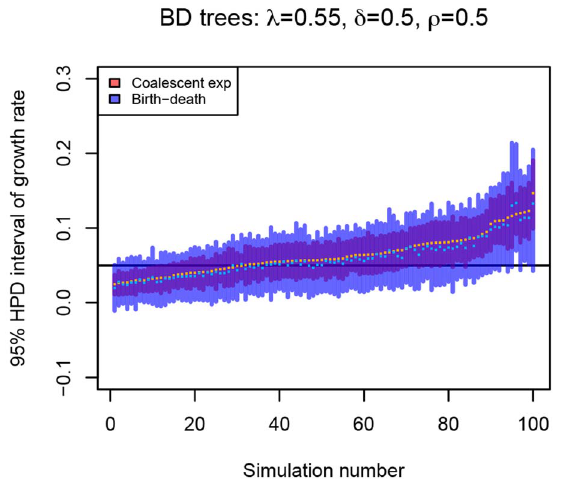
Figure 6. Comparison of the birth-death model and the coalescent model in estimating epidemic growth rate from trees with tips sampled at one point in time. For simulated trees where all 100 tips are sampled at one point in time, we estimated the growth rate parameter assuming a birth-death model with fixed sampling probability r ~ 0 : 5 (blue bars) and the coalescent model with a deterministic exponentially growing population (red bars). Here we used l ~ 0 : 55, d ~ 0 : 5 and sampling probability r ~ 0 : 5 ( R 0 ~ 1 : 1 ). See Figure S15 for the plots of other parameter settings.